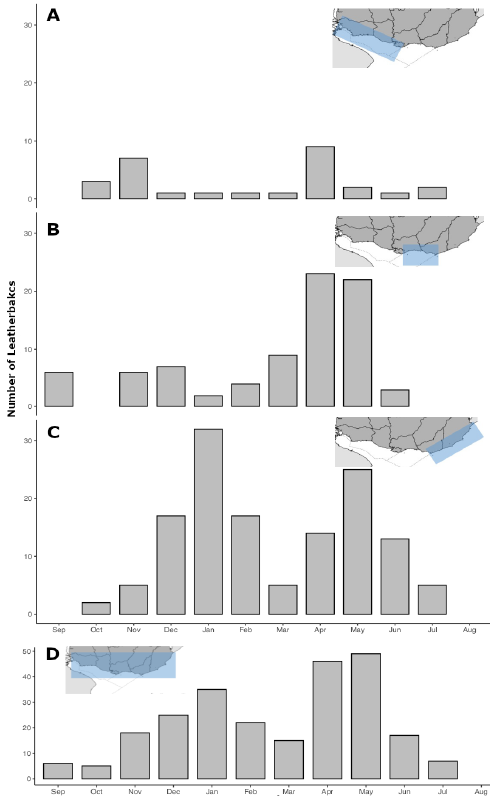
Figure 5. Number of stranded leatherbacks observed during the 25 years of the present study (1997–2021), per month, for each zone and all the Uruguayan coasts. ( A ) Inner estuarine zone (IEZ), ( B ) outer estuarine zone (OEZ), ( C ) oceanic zone (OZ), and ( D ) all the Uruguayan coasts (note the difference in the y -axis from the other panels). The blue polygon indicates the coastal area included in each panel.